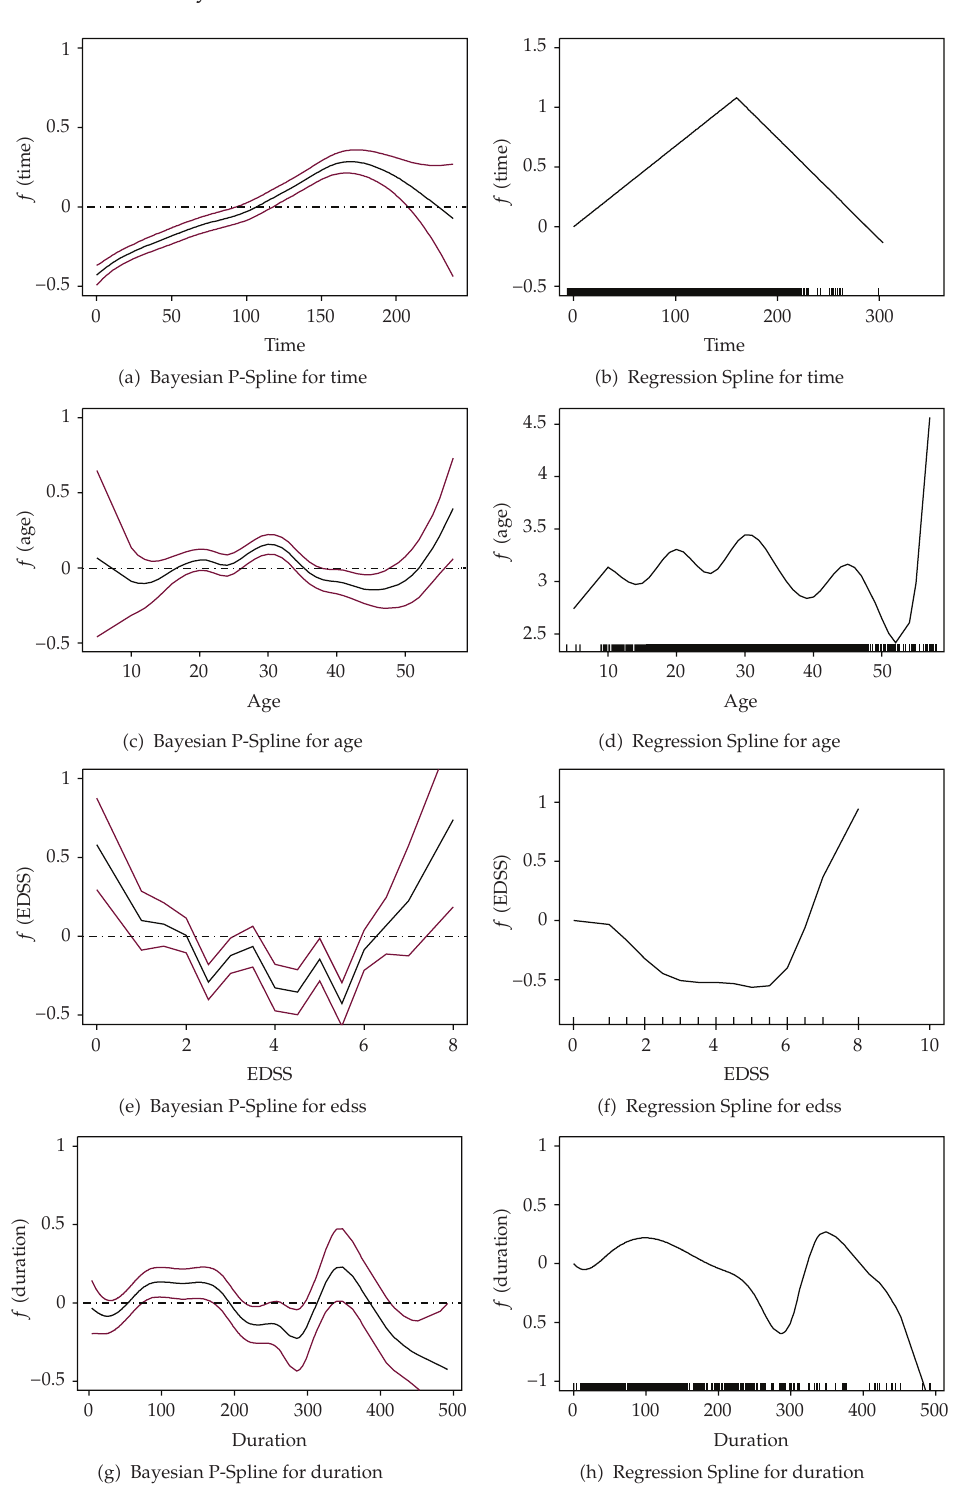
Figure 8: Estimation results for Gaussian model with no random e ff ect (cid:3) left (cid:4) and with random e ff ect (cid:3) right (cid:4)